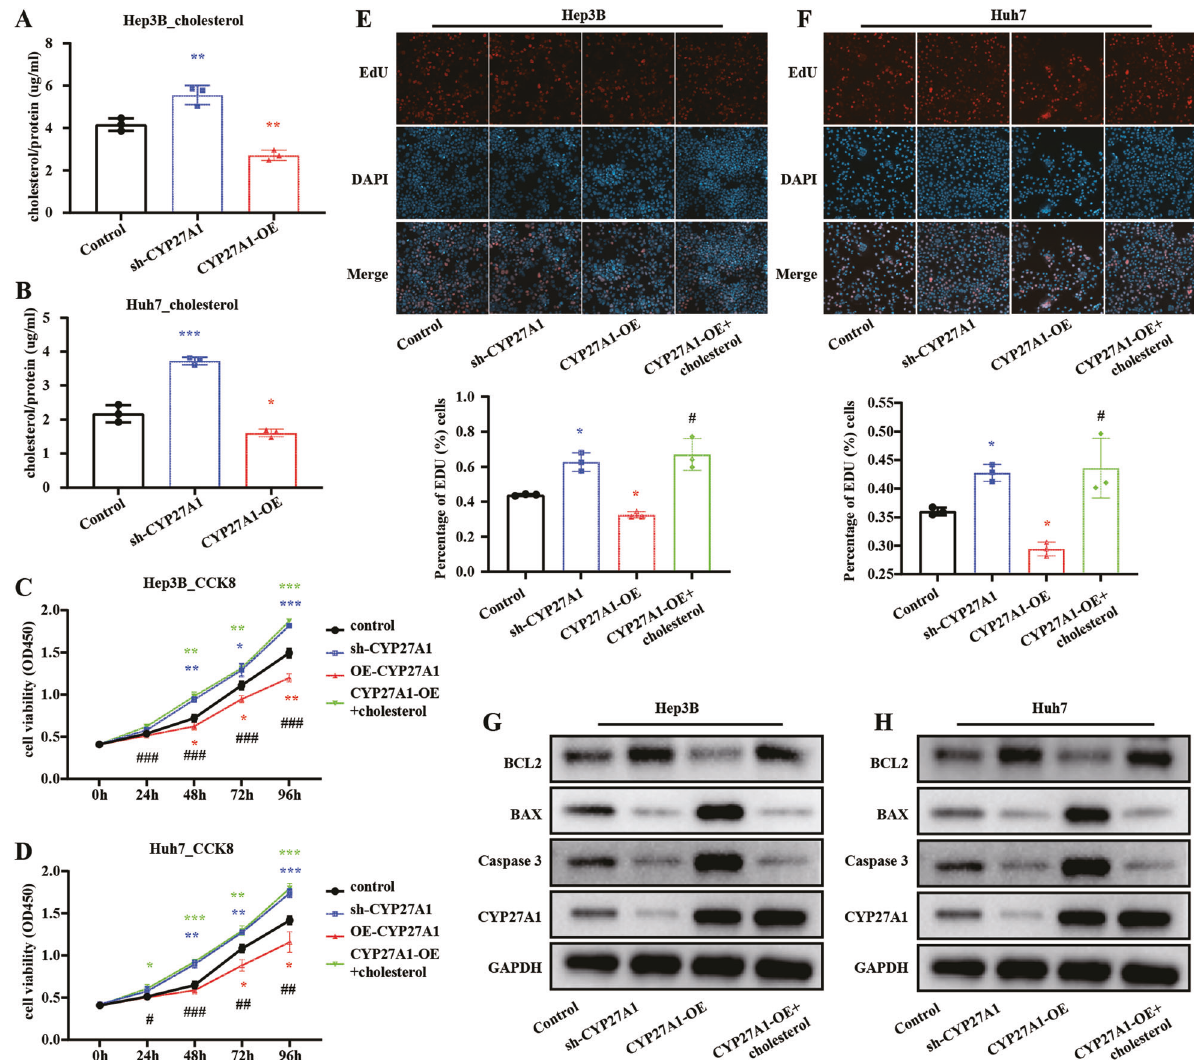
Fig. 4 CYP27A1 promotes HCC progression through modulating cholesterol degradation. A , B Cholesterol levels in Hep3B and Huh7 cells treated as shown. C – F Cell proliferation of Hep3B and Huh7 cells measured by CCK8 and EdU assays. Quanti fi cation of EdU results after indicated treatment. G , H Western blot analysis of apoptotic markers after different treatments of Hep3B and Huh7 cells. n = 3/per group. Experimental group compared to control group: * p < 0.05, ** p < 0.01, *** p < 0.001. CYP27A1-OE group compared to CYP27A1-OE + cholesterol group: # p < 0.05, ## p < 0.01, ### p <